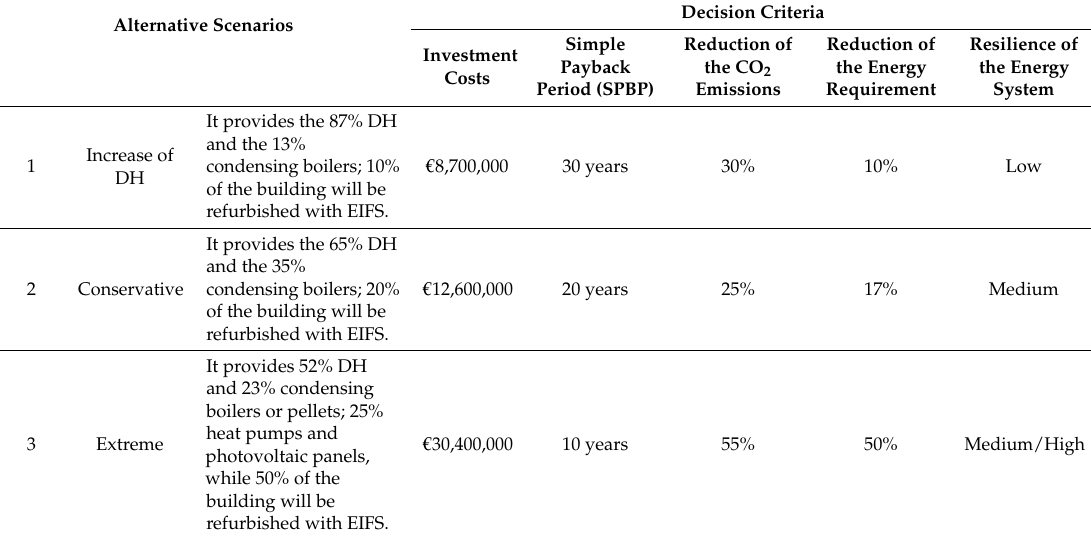
Table 1. The alternative scenarios and the decision criteria